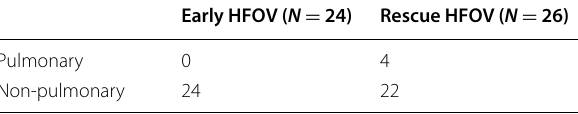
Table 4 Outcome measures